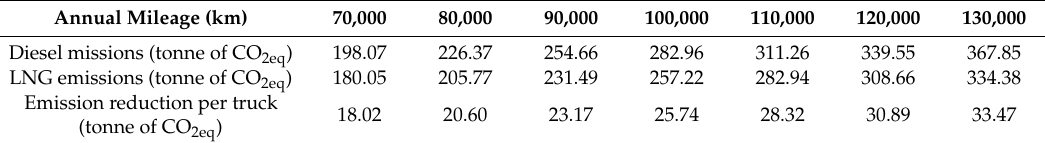
Table 4. Annual liquefied natural gas (LNG) truck GHG emission reduction.